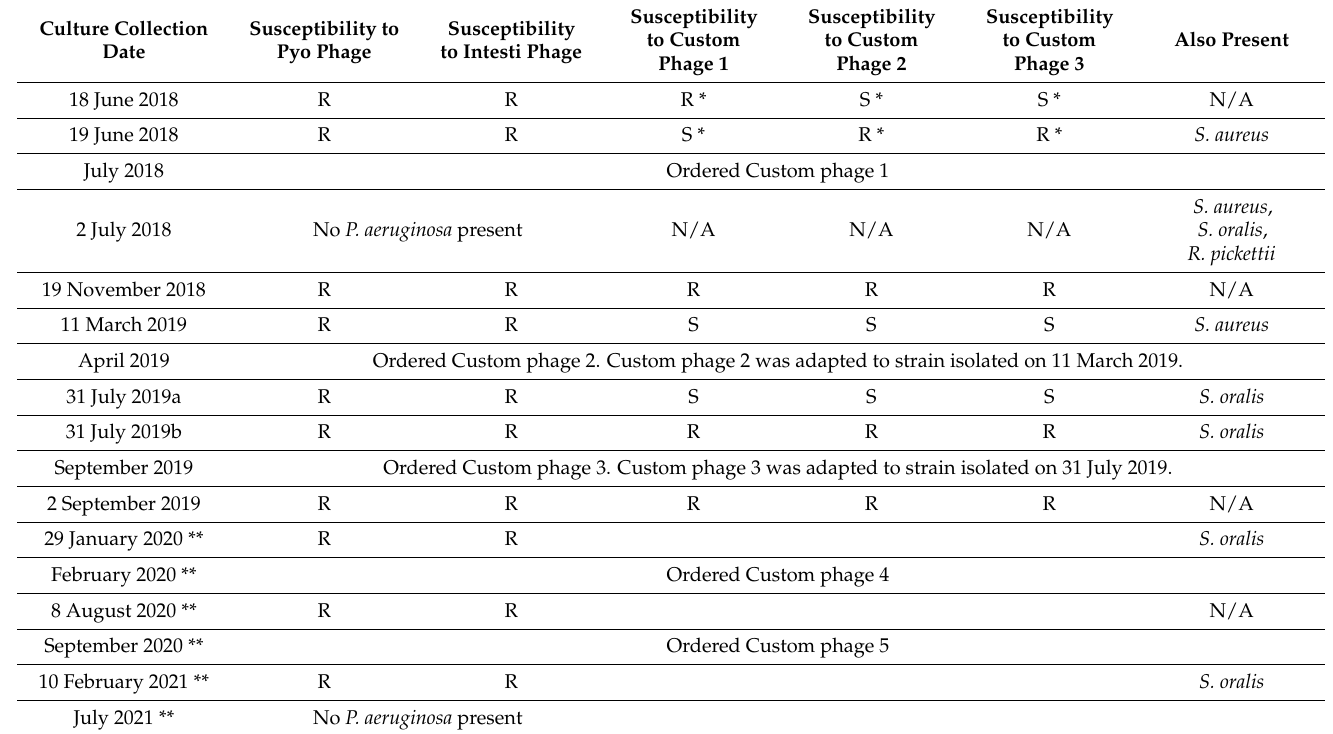
Table 3. Phage susceptibility of Pseudomonas aeruginosa sputum (all samples except for the one collected on 19 June 2018) and nose swab (collected on 19 June 2018) cultures of patient #2: strain sensitive to phage (S), strain resistant to phage (R). Two strains of Pseudomonas aeruginosa were isolated from morphologically distinct colonies (31 July 2019a—greenish blue colony variants, 31 July 2019b—pale pinkish colony variants) found in the same sputum sample. * Custom phage susceptibility of strains isolated before custom phage preparation. ** Custom phages and bacterial strains from 2020 or later were not included in the